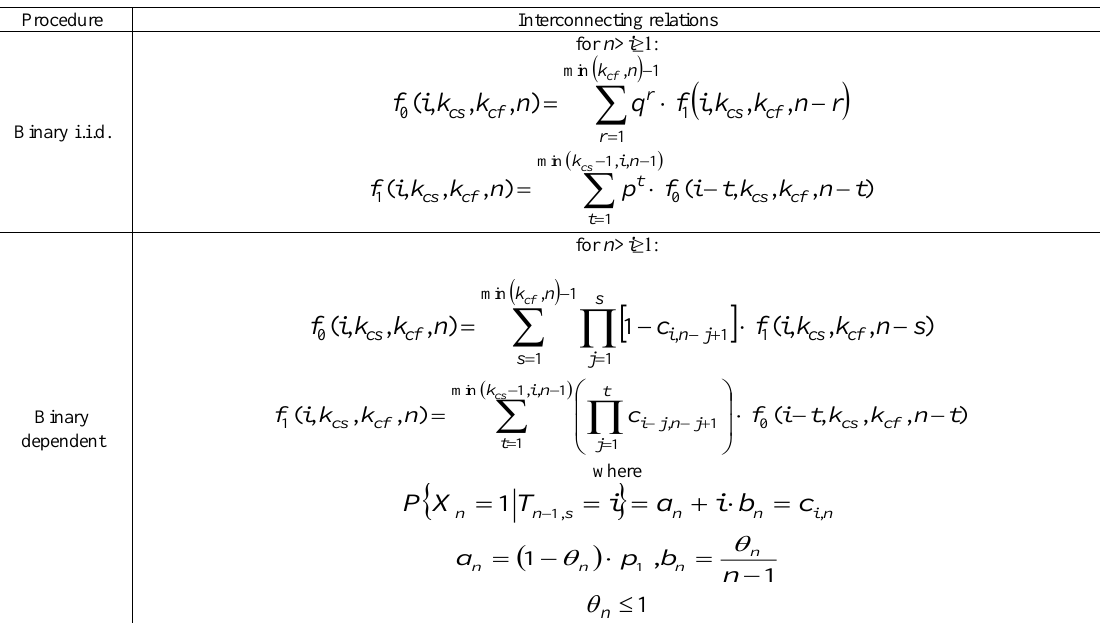
Table 3.The interconnecting relations between the auxiliary